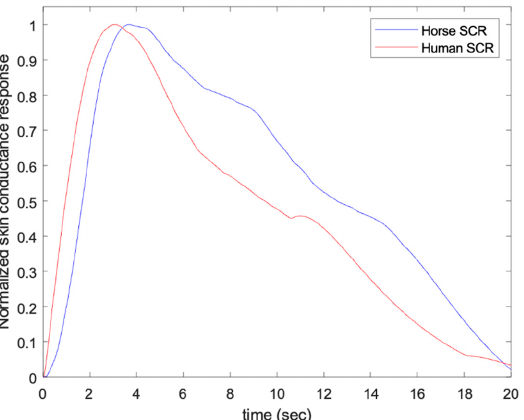
Figure 2. Samples of normalized skin conductance responses (SCRs) of human and horse.